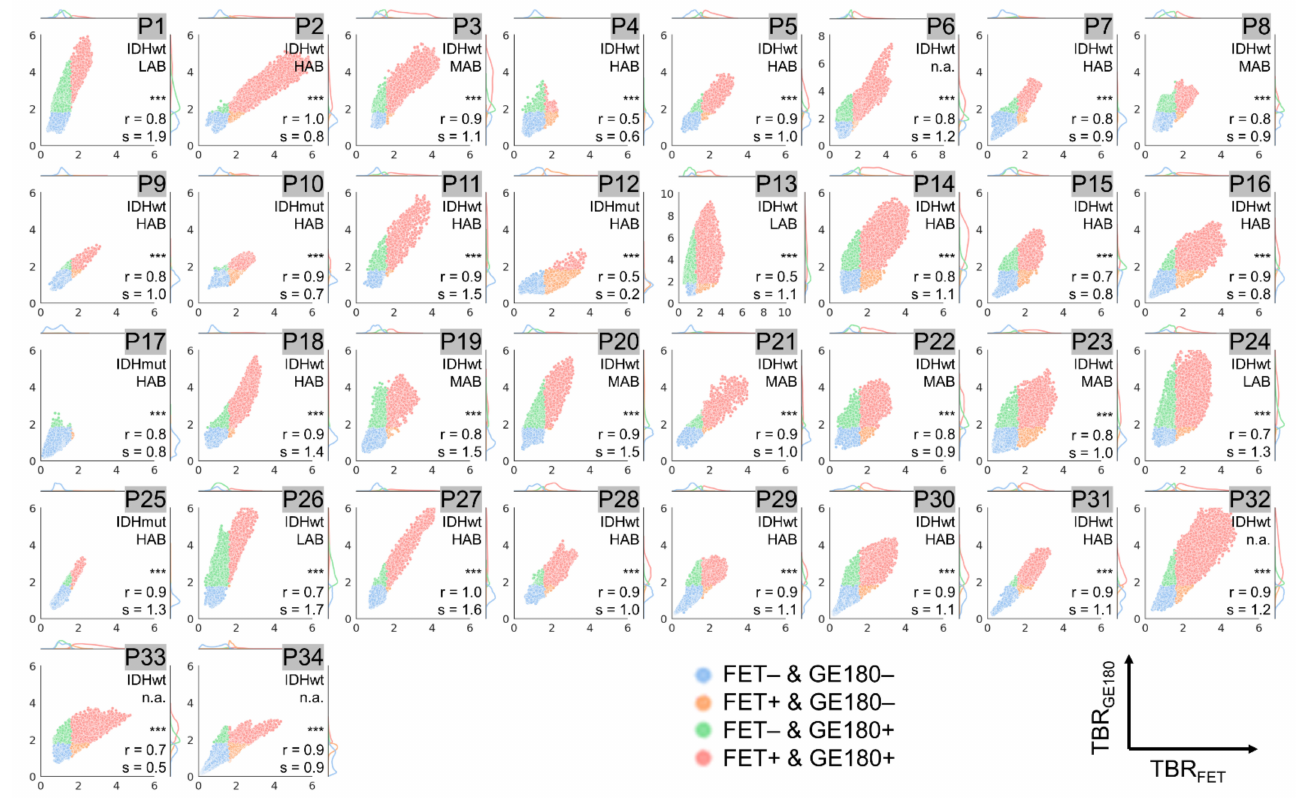
Figure 5. Voxel-wise correlation of tumor-to-background ratios TBR GE180 and TBR FET for patients P1–P34. The depicted data points are color coded as described in Figure 2: Red: TBR FET and TBR GE180 positive voxels, Blue: TBR FET and TBR GE180 negative voxels, Orange: TBR FET positive and TBR GE180 negative voxels, Green: TBR FET negative and TBR GE180 positive voxels. Significances obtained from Pearson’s correlation and the corresponding correlation coefficients (r) and slopes (s) are provided in the lower right corner. Significance was grouped as strong ( p < 0.001, denoted with ***). The status of IDH mutation (IDHmut: with IDH1/2 mutation; IDHwt: without mutation) and the TSPO- polymorphism genotype are given for each patient in the upper right corner (if not available denoted with n.a.). The axis ranges are all fixed to values between zero and six except for patients P6 and P13 where the upper limit was adapted due to higher voxel